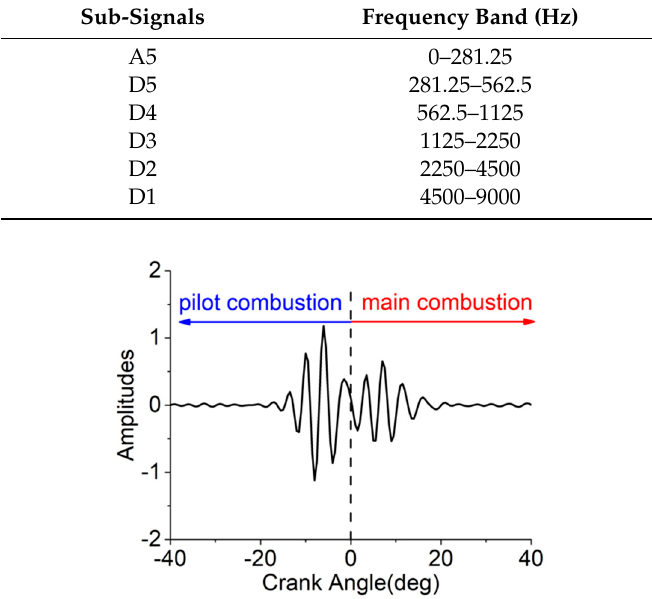
Table 3. Frequency band of each sub-signal in stationary wavelet transforms.